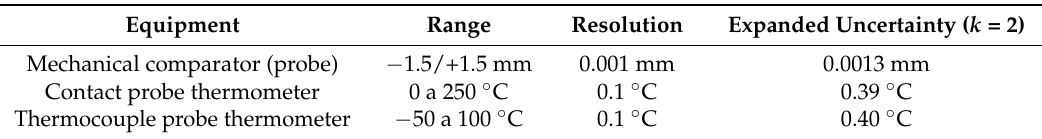
Table 1. Components of the measurement system.